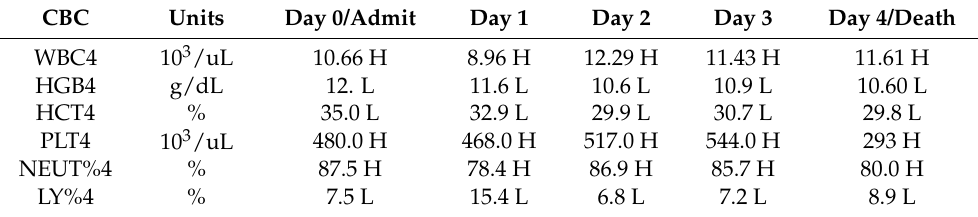
Table 4. Complete blood count (CBC) profile.